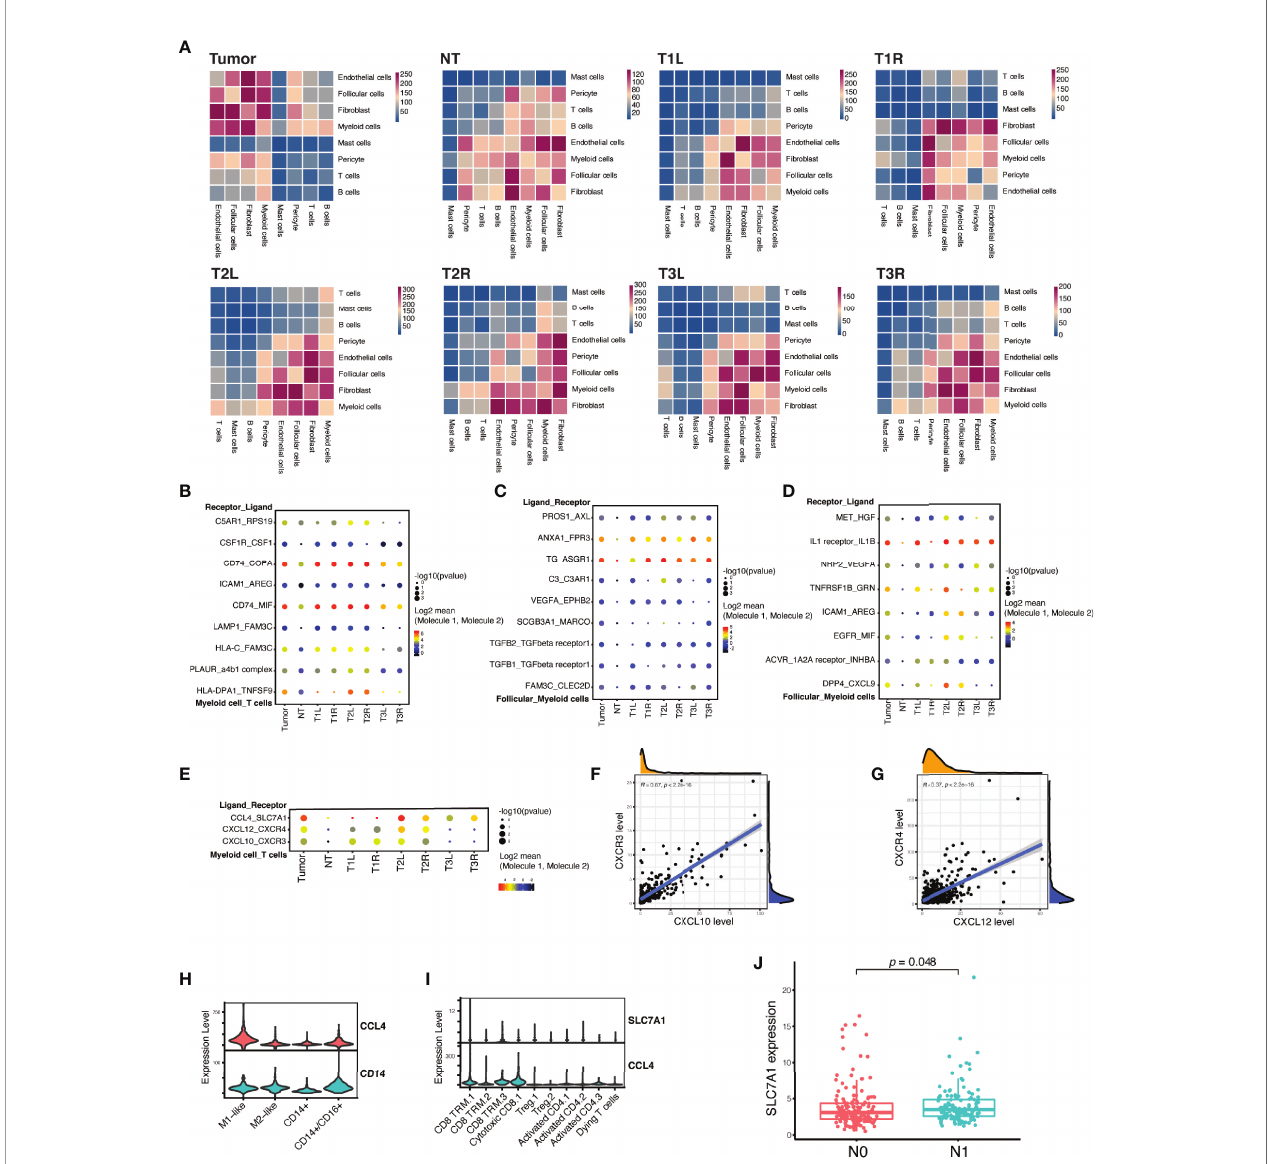
FIGURE 5 | Myeloidcellsand T cells formed inhibitoryinteractionsinpapillarythyroid carcinoma. (A) Heatmapofthe number of signi fi cant ligand – receptorinteractions amongdifferent celllineages demonstrating a substantial heterogeneity between tumor andnon-tumor (NT) thyroidsamples, as wellas between bilateral thyroid cancer samples fromthe samplepatient. (B) Highlighted signi fi cant interactionsbetween myeloidcells and T cells showingmultipleinteractionsthat promote M2-likemacrophage polarization. (C) Highlightedsigni fi cant interactionsbetween myeloid cells andfollicular cellsshowingmultipleinteractions that induce M2-likemacrophage polarization. (D) Highlighted signi fi cant interactionsbetween myeloid cells and follicular cells showingmultipleinteractionsthat drive tumor growth,motility,and metastasis. (E) Highlighted signi fi cant interactionsbetween myeloidcells and T cells showingmultipleinteractionsthat recruitT cells, but dampen T-celldifferentiation. (F) Strong linear correlation between the expressions of CXCL10 and CXCR3 in The Cancer Genome Atlas (TCGA)cohort of patients with PTC ( n = 507). (G) Stronglinear correlation between the expressions of CXCL12 and CXCR4 in TCGA cohort of patients with PTC ( n = 507). (H) Violin plots showingthe expression of CCL4 inmyeloid cells. (I) Violin plots showing the expression of SLC7A1 incytotoxicCD8 and CD8TRMT cells. (J) A highexpression of SLC7A1 was associated with lymph node metastasis inTCGA cohort ofpatients with PTC ( n = 281). N0 indicates noregional lymph nodemetastasis, while N1 indicates the presence oflocal lymph